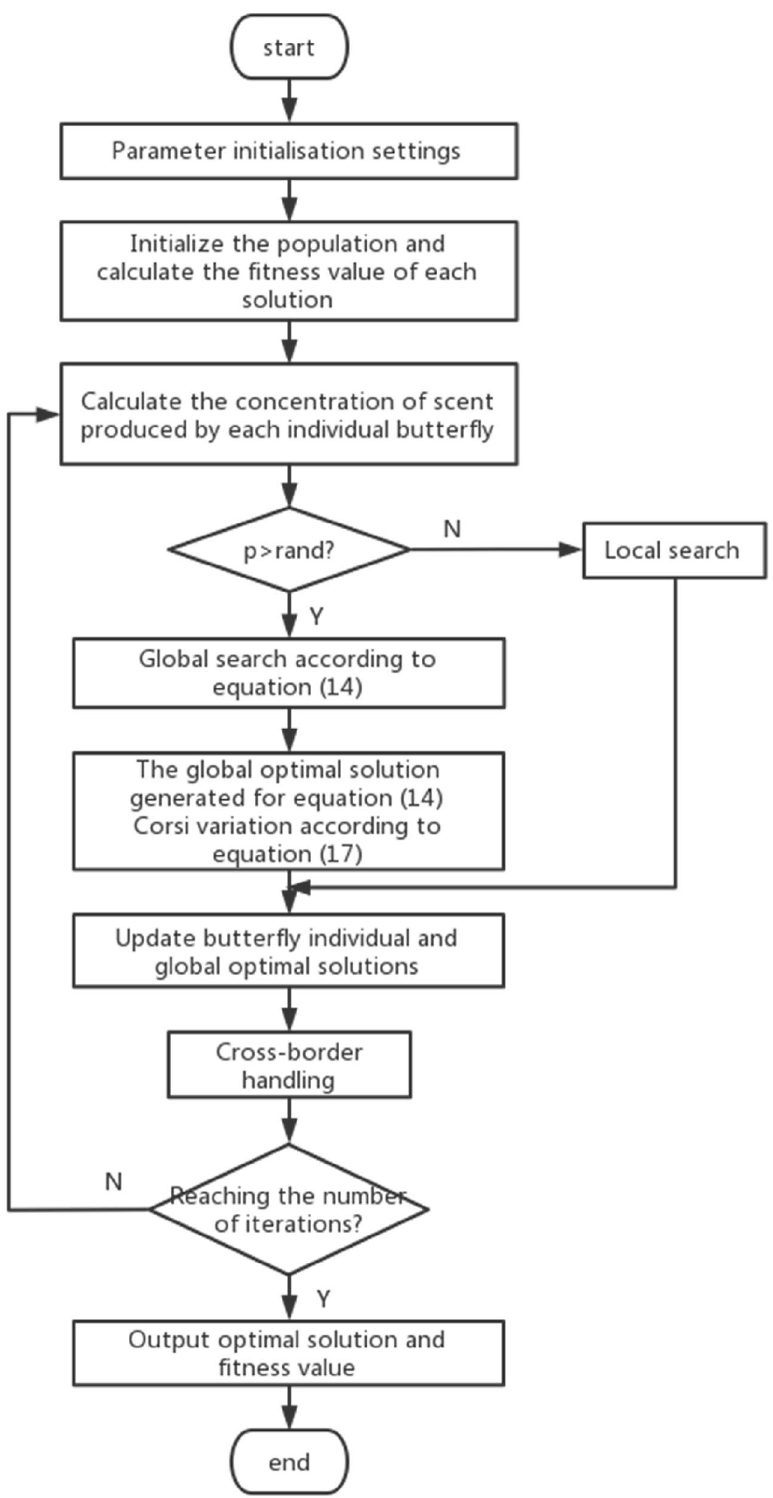
Figure 3. Steps of